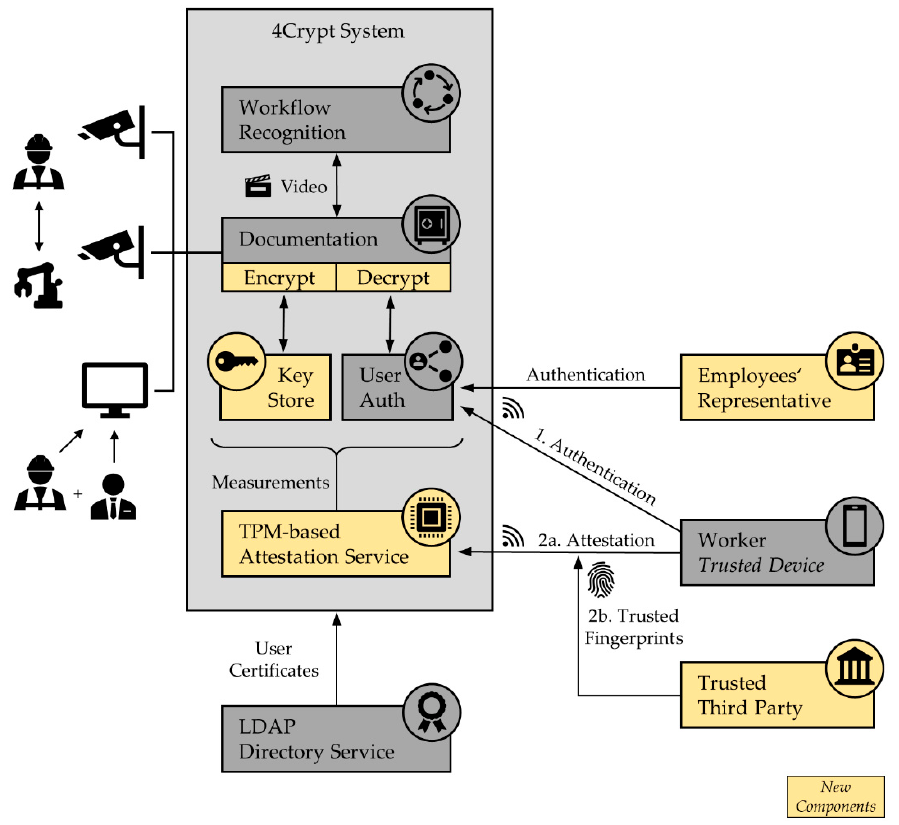
Figure 3. 4Crypt system design.